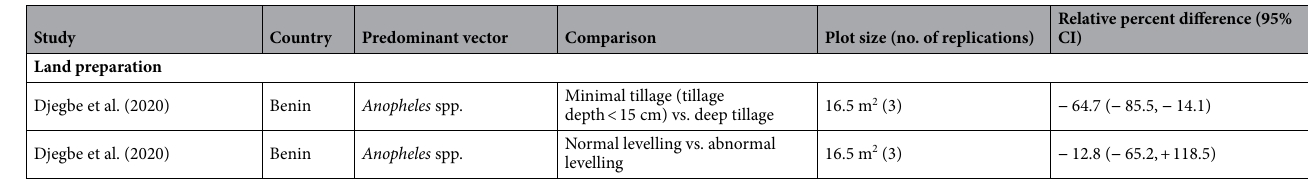
Table 3. Summary of findings of meta-analyses of the effect of rice cultivation practices on Anopheles larval density (the number of larvae and pupae per dip or area sampler), arranged by the type of control, study design and geographical region. Significant values are in bold. *Water is applied to the field so that it is wet for X days and left for X days to dry before being irrigated again. 1 DAS: Days after seeding. 2 TP: Transplanting. 3 DAT: Days after transplanting. 4 EC: Emulsifiable concentrate.